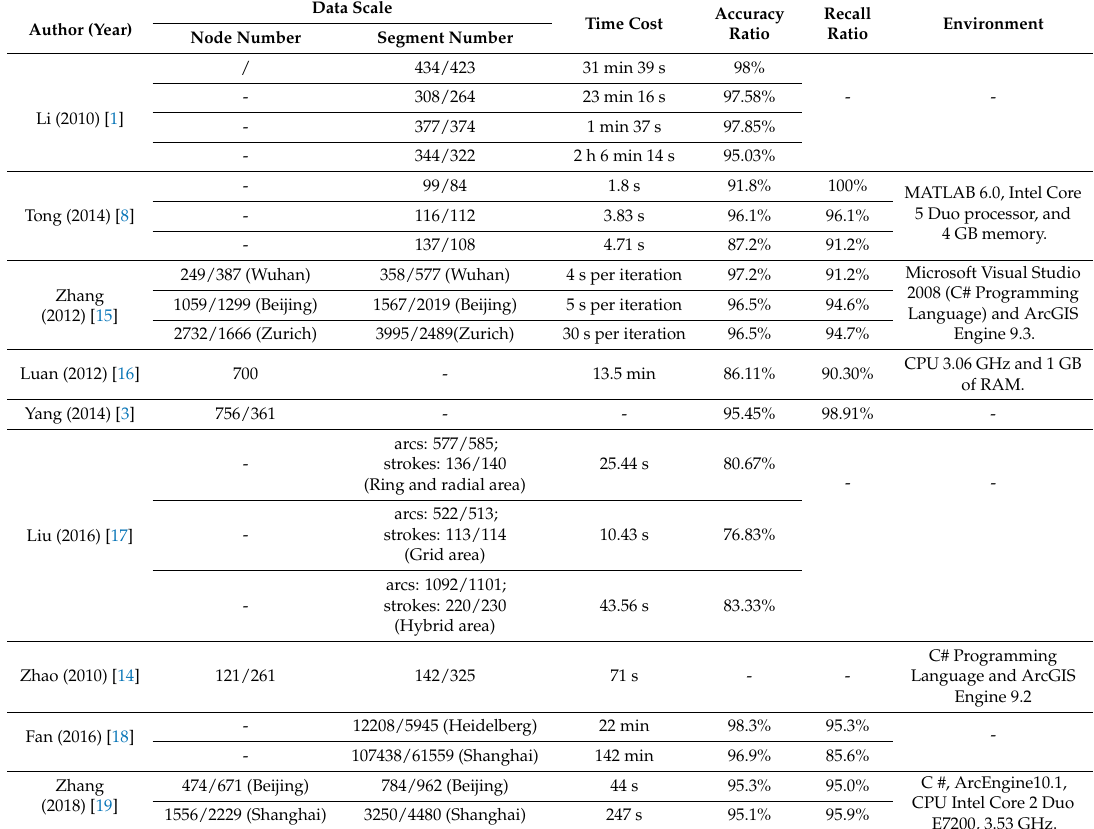
Table 1. Studies that mention the performance of road-network matching algorithms (listing data scale, time cost, accuracy, recall, and